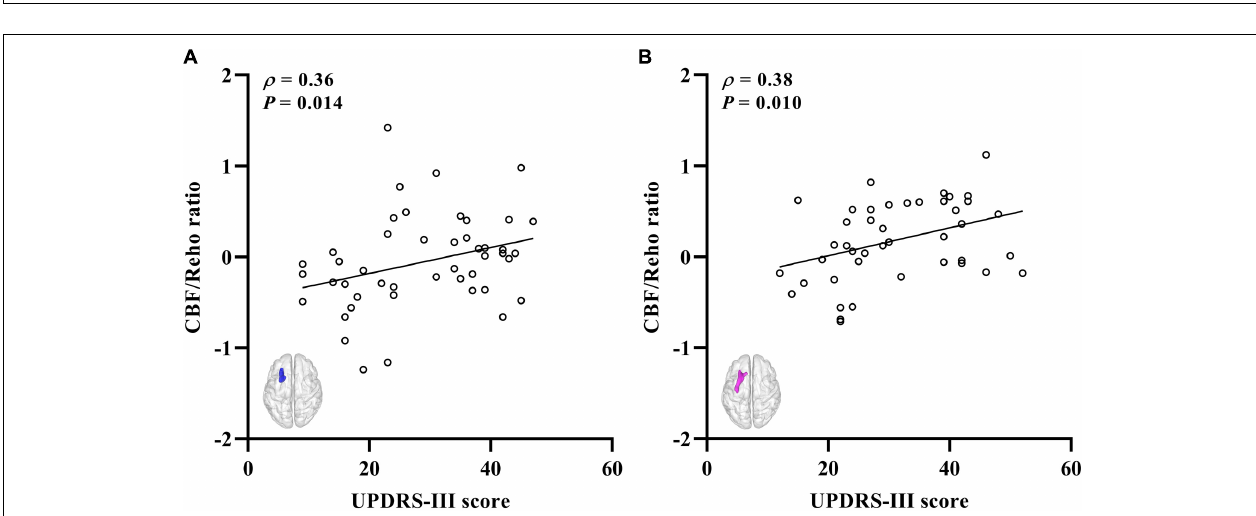
FIGURE 4 | The correlations between the CBF-ReHo ratio and scores of disease severity. (A) Correlations for the PD-NC group between the scores of UPDRS-III ( X -axis) and CBF-ReHo ratio in left putamen ( Y -axis); (B) correlations for the PD-MCI group between the scores of UPDRS-III ( X -axis) and CBF-ReHo ratio in left putamen ( Y -axis). CBF, cerebral blood flow; ReHo, regional homogeneity; PD, Parkinson’s disease; NC, normal cognition; MCI, mild cognitive impairment; UPDRS, Unified Parkinson’s Disease Rating